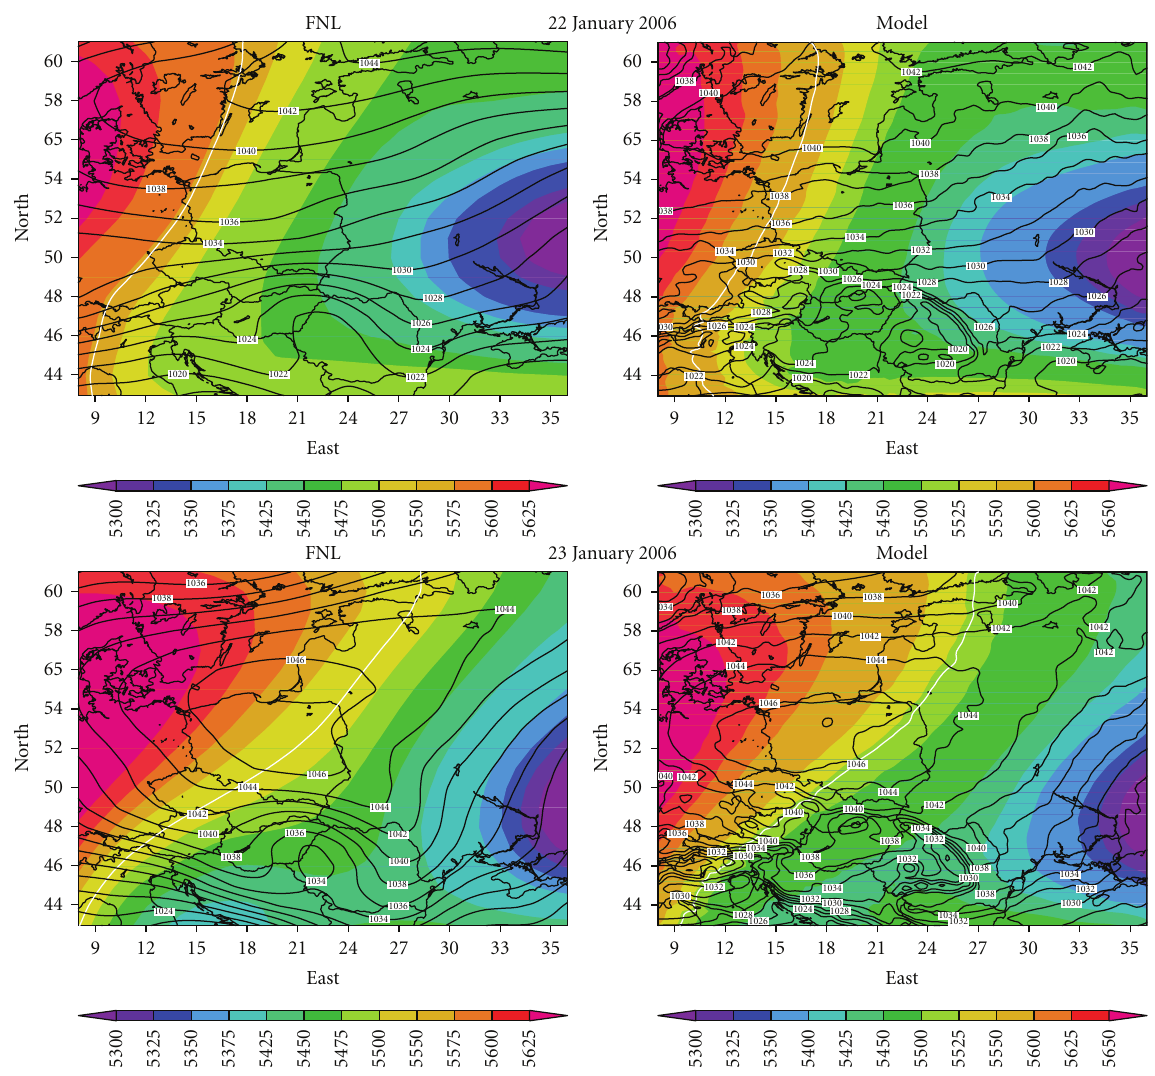
Figure 6: Daily mean geopotential height (gpm) at 500 hPa level (shaded) along with Surface pressure (hPa) (contours) for FNL (left panel) and ARW model (right panel) at di ff erent